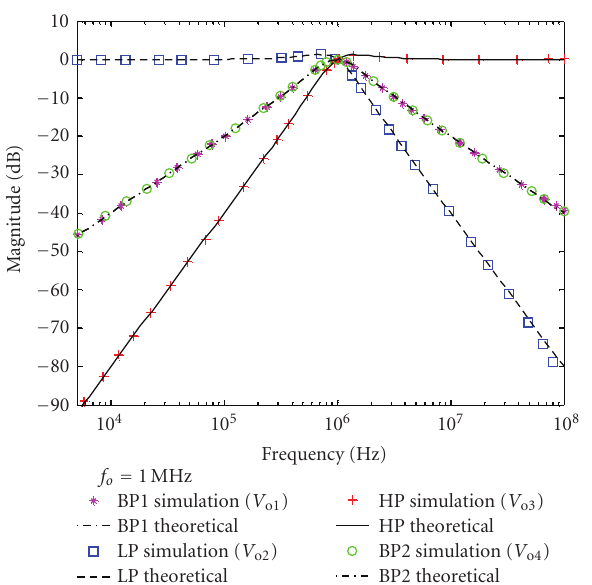
Figure 3: Simulated frequency responses of highpass, bandpass, and lowpass of Figure 1 at f o = 1 MHz and Q = 1.